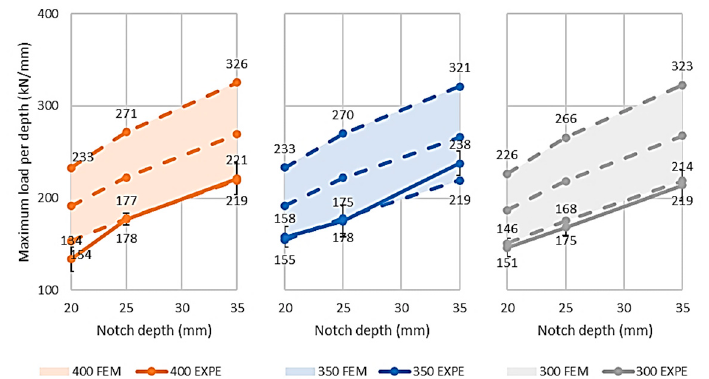
Figure 17. FEM envelop of maximum load Fmax per notch depth.